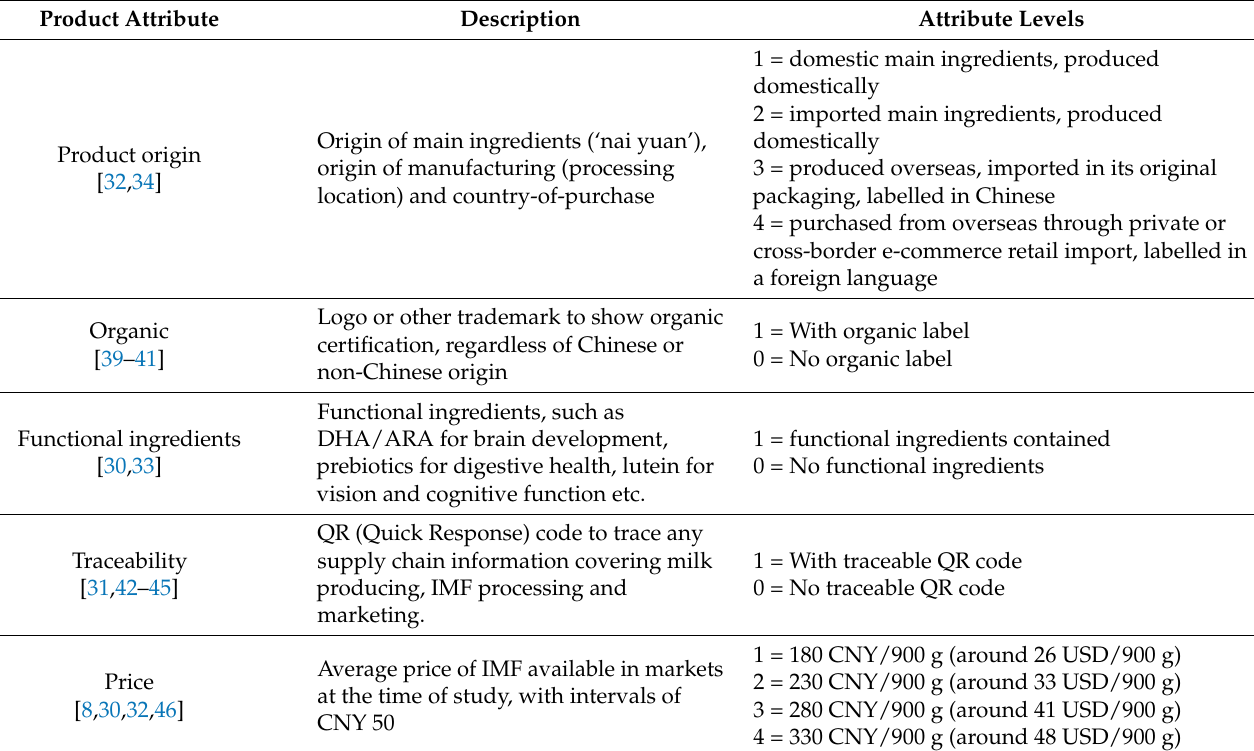
Table 1. Product attributes and attribute